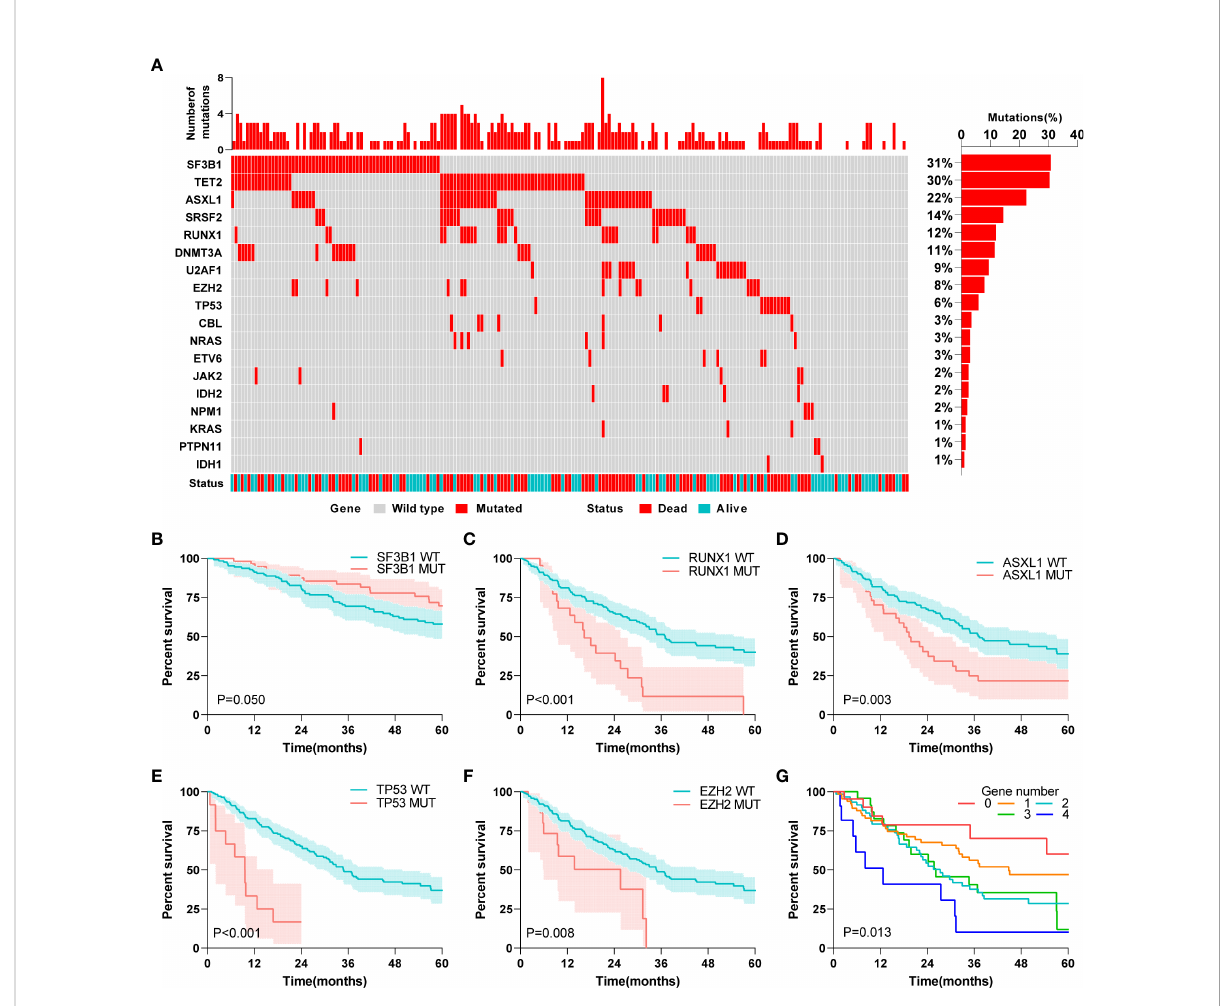
FIGURE 2 Association between gene mutations and MDS patients ’ prognosis. (A) Landscape pro fi le of 18 somatic gene mutations in 201 MDS patients. Mutations of each genes in each patient were shown in waterfall plot. Each column presented each patient. The left is the number of mutations in each patient, and the right is the mutation frequency of the gene in 201 patients. (B) Kaplan-Meier analysis of SF3B1 wild-type and mutant MDS patients. (C) Kaplan-Meier analysis of RUNX1 wild-type and mutant MDS patients. (D) Kaplan-Meier analysis of ASXL1 wild-type and mutant MDS patients. (E) Kaplan-Meier analysis of TP53 wild-type and mutant MDS patients. (F) Kaplan-Meier analysis of EZH2 wild-type and mutant MDS patients. (G) Kaplan-Meier analysis of MDS patients with different numbers of mutated genes. The log-rank test was used to compare survival rates between the two